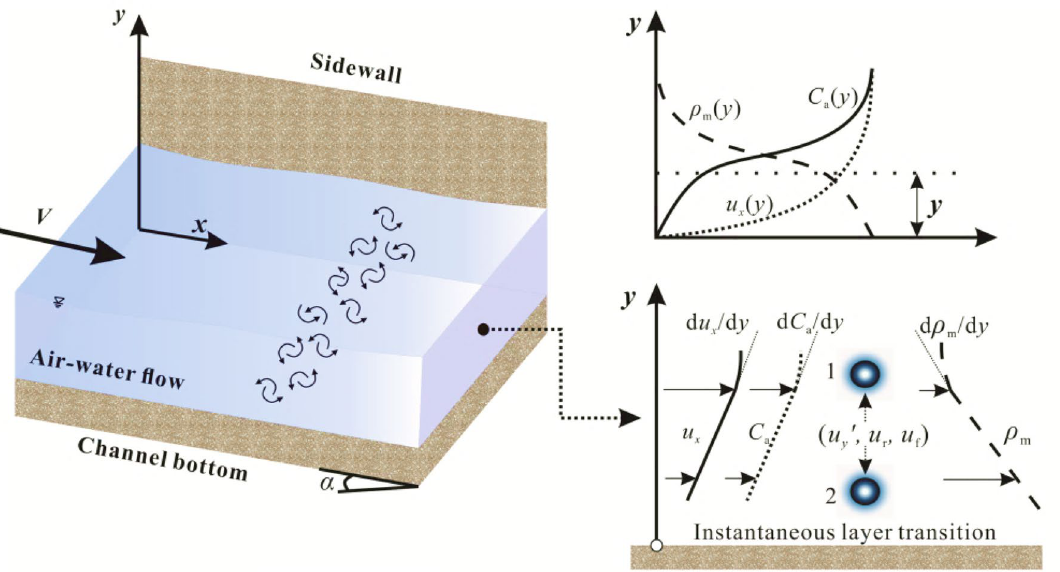
Figure 2. Schematic definitions for the turbulence fluctuations of air–water mixture parcels ( α is the channel